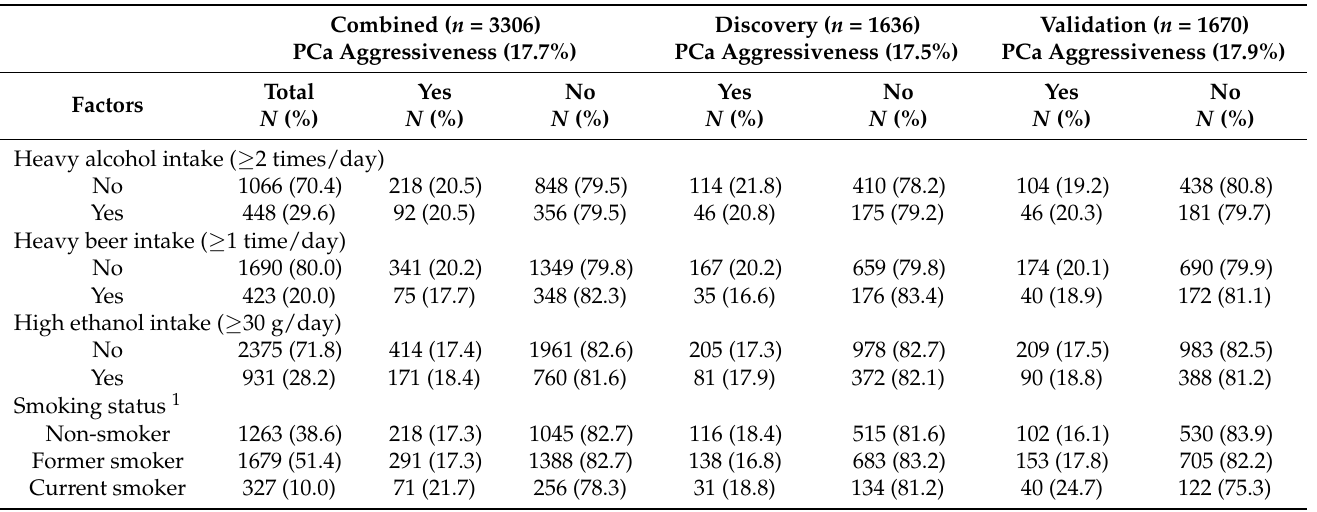
Table 1. Alcohol intake and smoking status associated with prostate cancer (PCa) aggressiveness by study